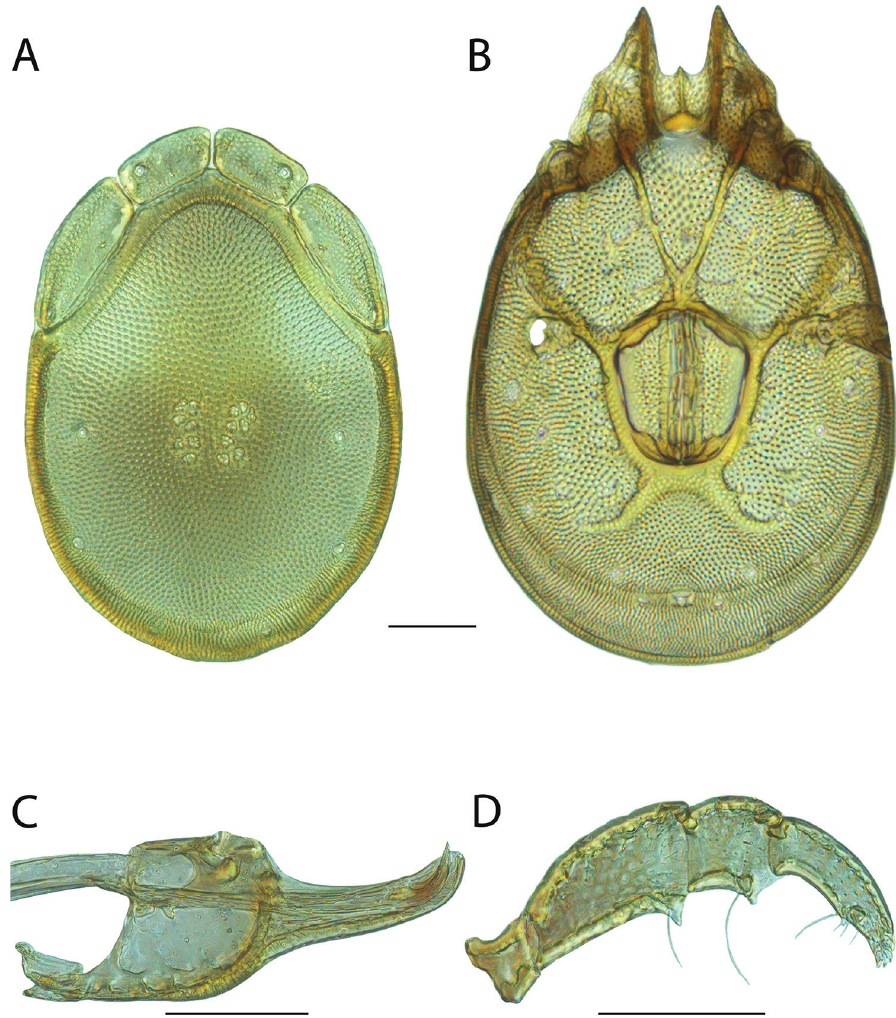
Figure 218. Torrenticola reduncarostra sp. n. female: A dorsal plates B venter (legs removed) C subca- pitulum D pedipalp (setae not accurately depicted). Scale = 100